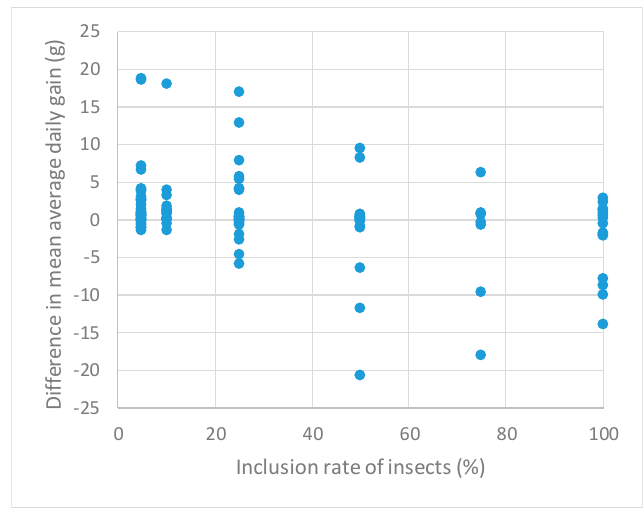
Figure 5. Di ff erences in means of the average daily gain between poultry fed a diet with vs. without insects per rate of their inclusion in the